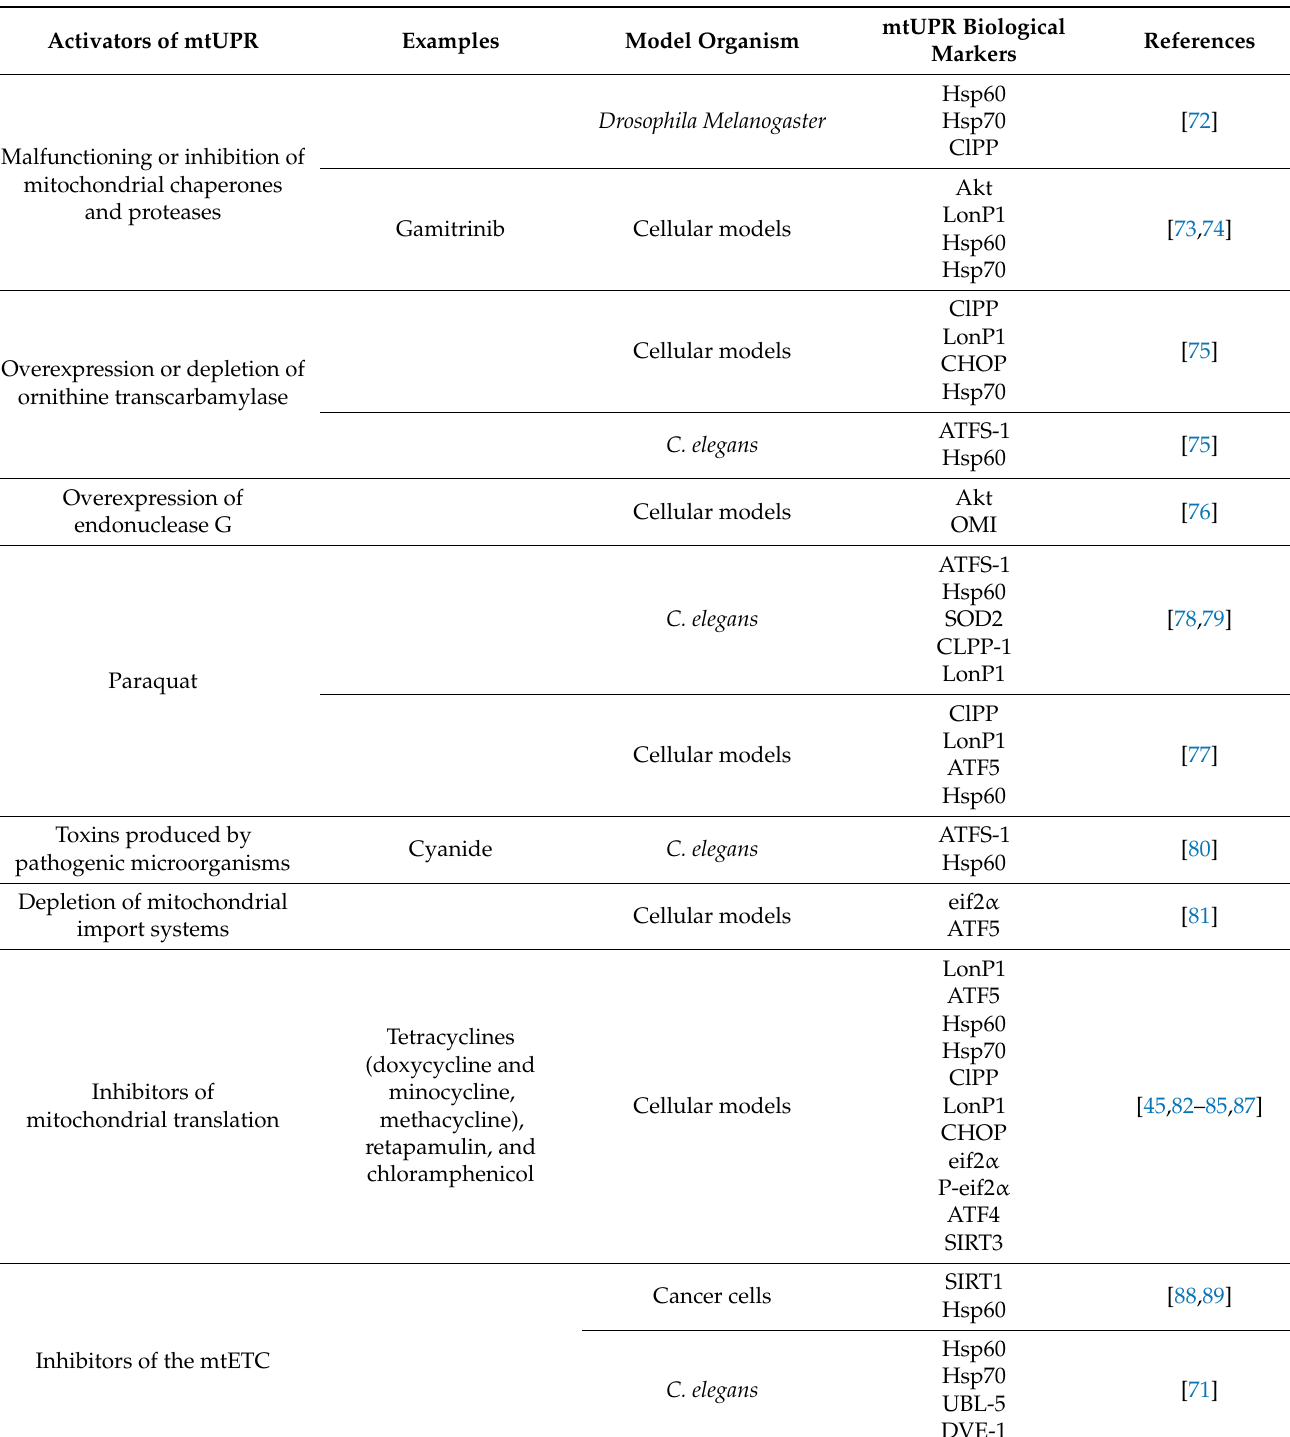
Table 1. mtUPR activators. This table summarizes the different mtUPR activators, including the model organism in which they were experimentally assessed and the mtUPR biological markers that are upregulated in each